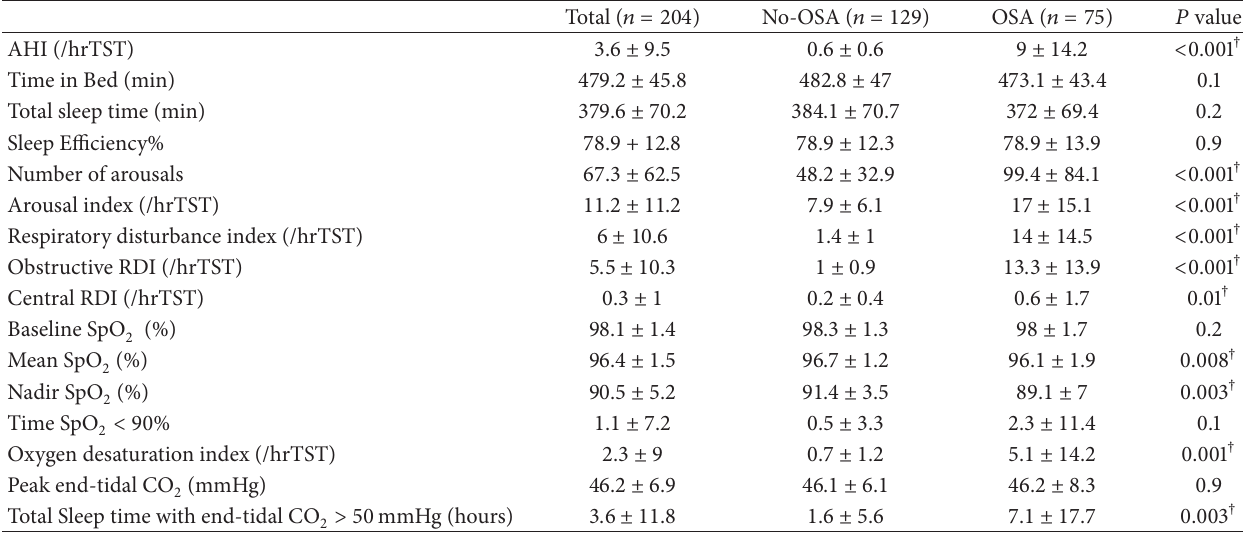
Table 2: Polysomnographic characteristics in OSA and no-OSA obese